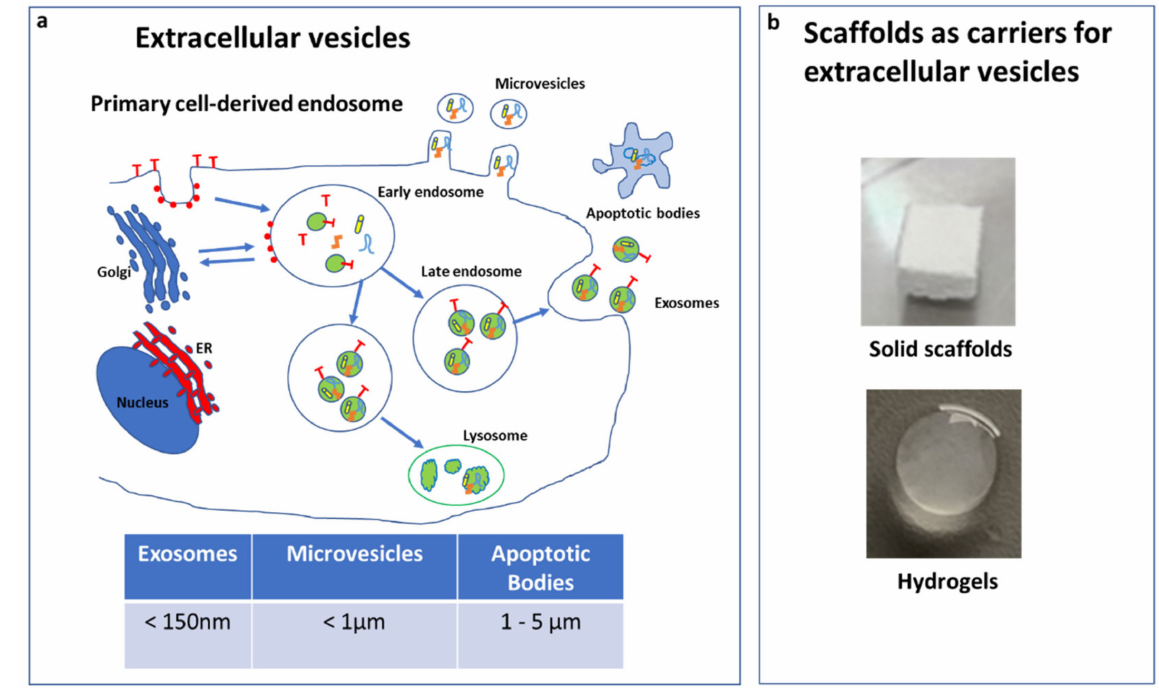
Figure 1. Extracellular vesicle (EV) types and dimension ( a ). Scaffolds used as carriers for EVs ( b